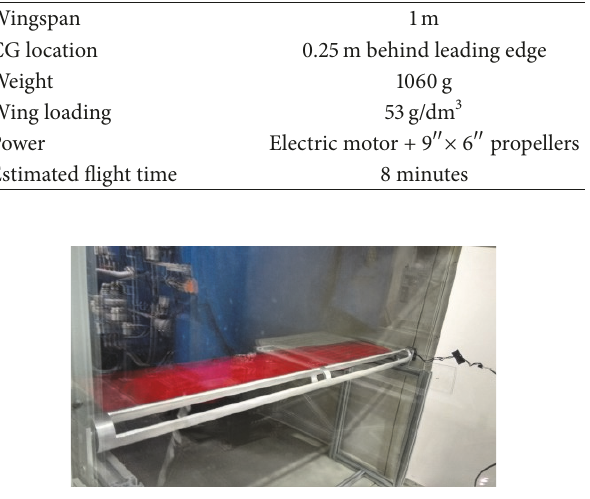
Figure 14: Gust generator with a rotating slotted